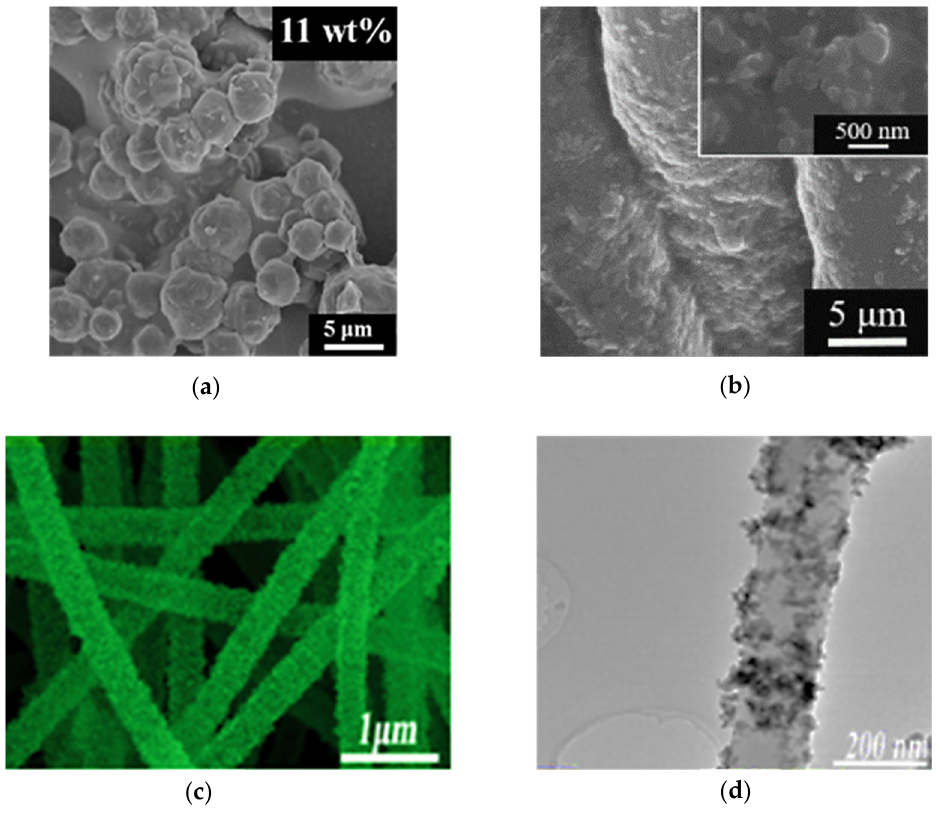
Figure 11. SEM images of ( a ) ZIF-ZnSe-NC-11 wt% [86], ( b ) BN/s-PT-50 [87], and ( c ) Bi 2 MoO6/CNFs [89]. ( d ) The TEM image of Bi 2 MoO 6 /CNFs [89]. Chen et al. obtained a boron nitride/sulfonated poly(thiophene-3-[2-(2-methoxyethoxy)